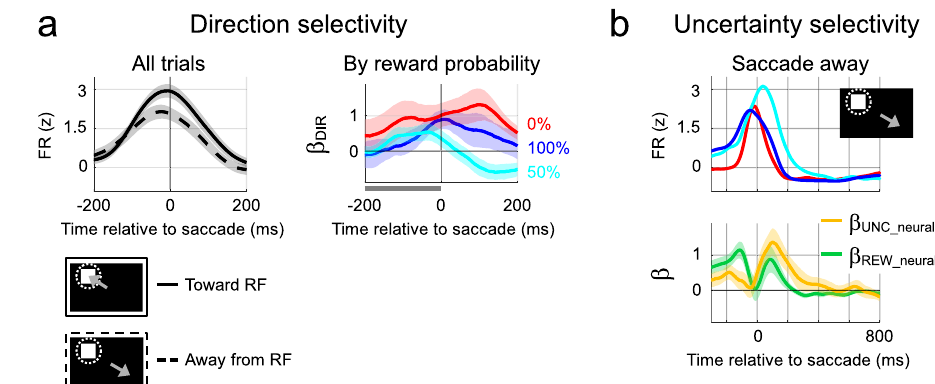
Fig.3|Uncertaintyandsaccadedirection.a Directionalselectivity.(Left)PSTHof activity aligned on saccade onset, pooled across reward probabilities for the geometrydepictedinthecartoons(maskinsidetheRFandsaccadestoward(solid) andaway(dashed)fromtheRF).Thetracesshowmeanand±2SEMforallcellswith suf fi cient trials in each condition (saccade away, n =68; saccade toward, n =52). (Right) Directional selectivity by reward probability. Time-resolved regression coef fi cientscapturingtheeffectofsaccadedirection( β DIR )inthesametrialsasleft panel separated by reward probability (mean and ±2 SEM across cells with